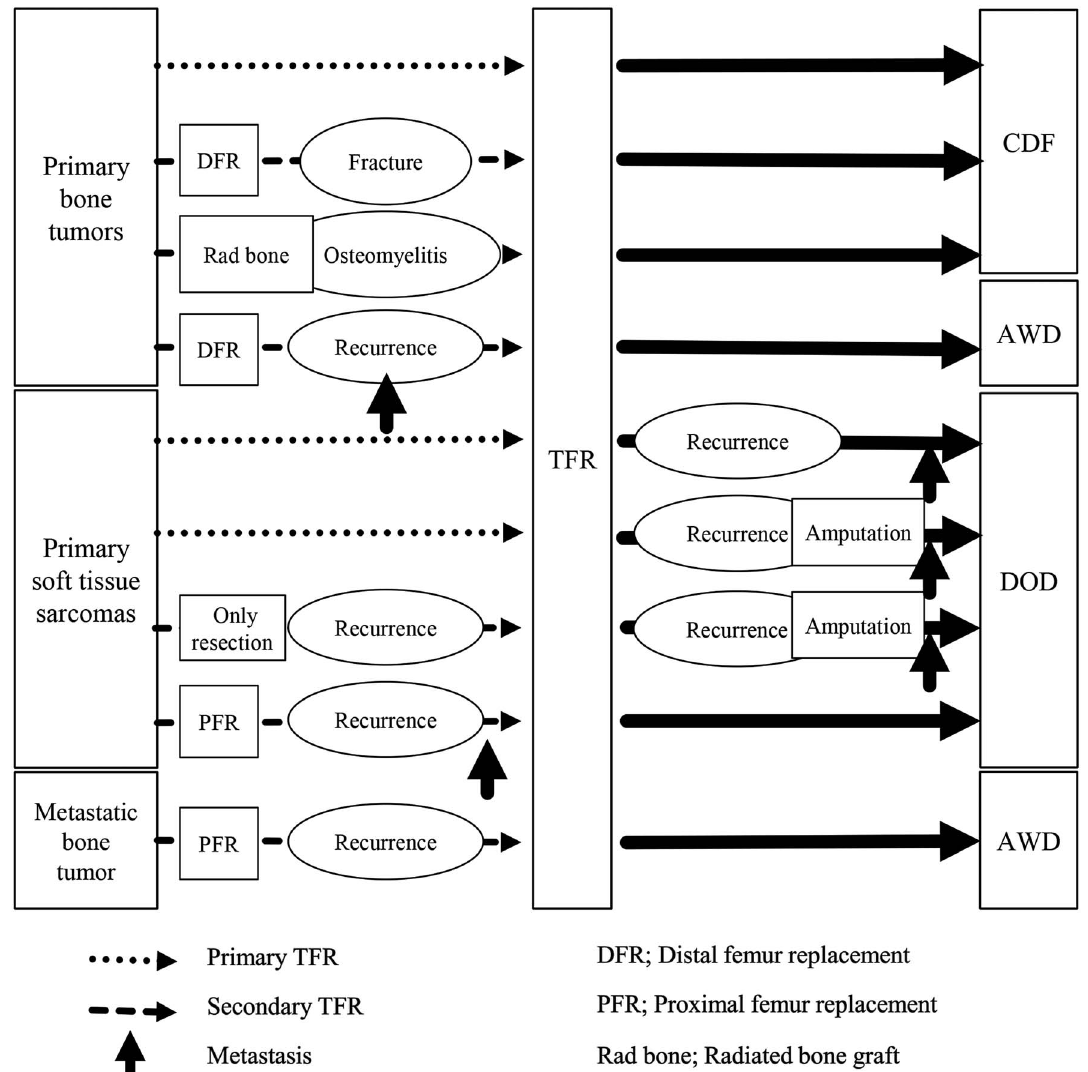
Figure 4. Kaplan – Meier survival curves for all patients.